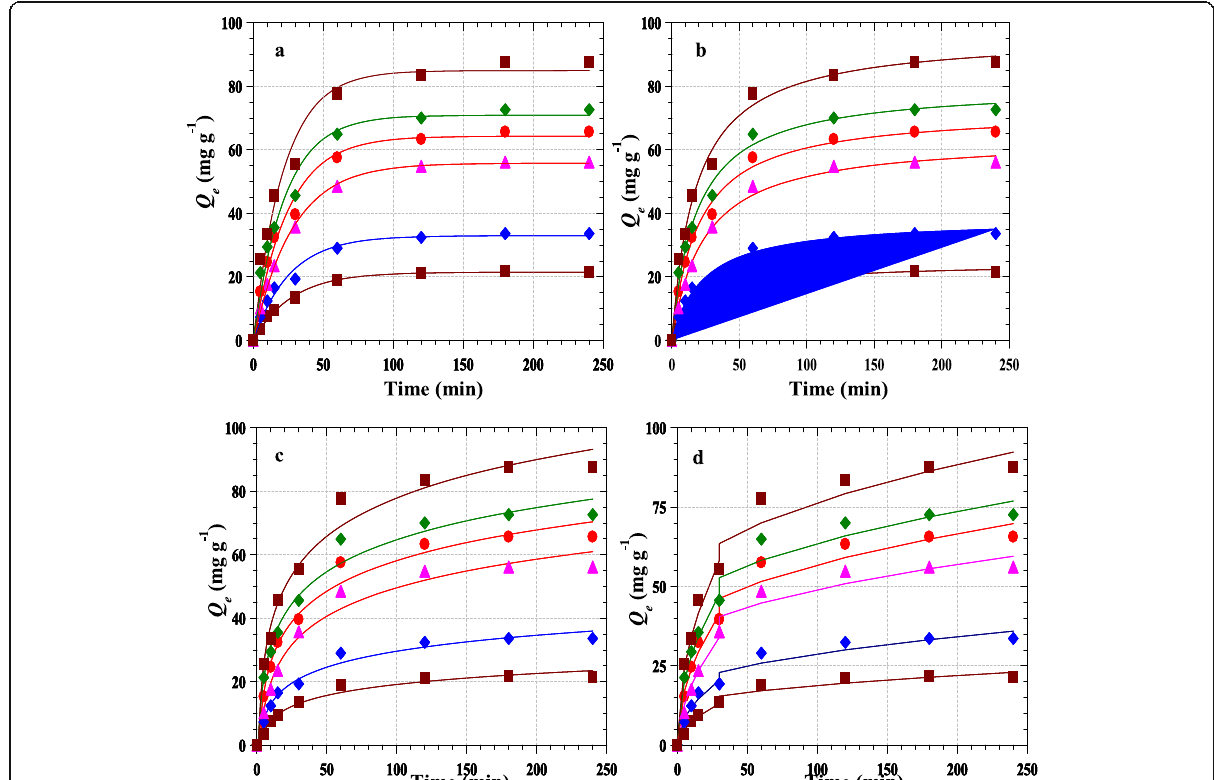
Fig. 13 Least square fit of Q t versus t of kinetic plots for the uptake of Cd(II) ions on BMDA ( a ) first-order ( b ) second-order ( c ) Elovich fits and ( d ) Intraparticle diffusion models. (Adsorbent dosage: 0.04 g/L, Temp: 30 °C, pH: 4.5 for RY4 dye